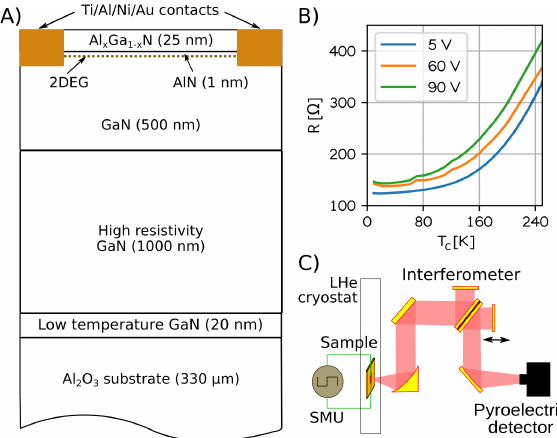
Figure 1. The layer composition of investigated AlGaN/GaN HEMT structure ( A ). Sample resistance dependencies on cryostat temperature at U p = 5 V, 60 V and 90 V ( B ). Schematics of spectroscopic experimental setup ( C